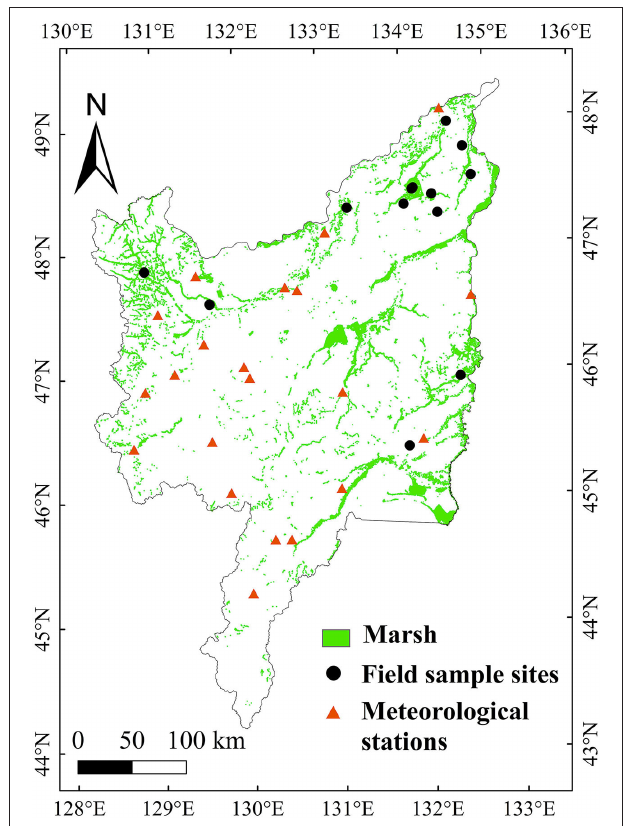
FIGURE 1 | Distributions of the marsh, meteorological stations, and sample sites of aboveground biomass (ABG) at the Sanjiang